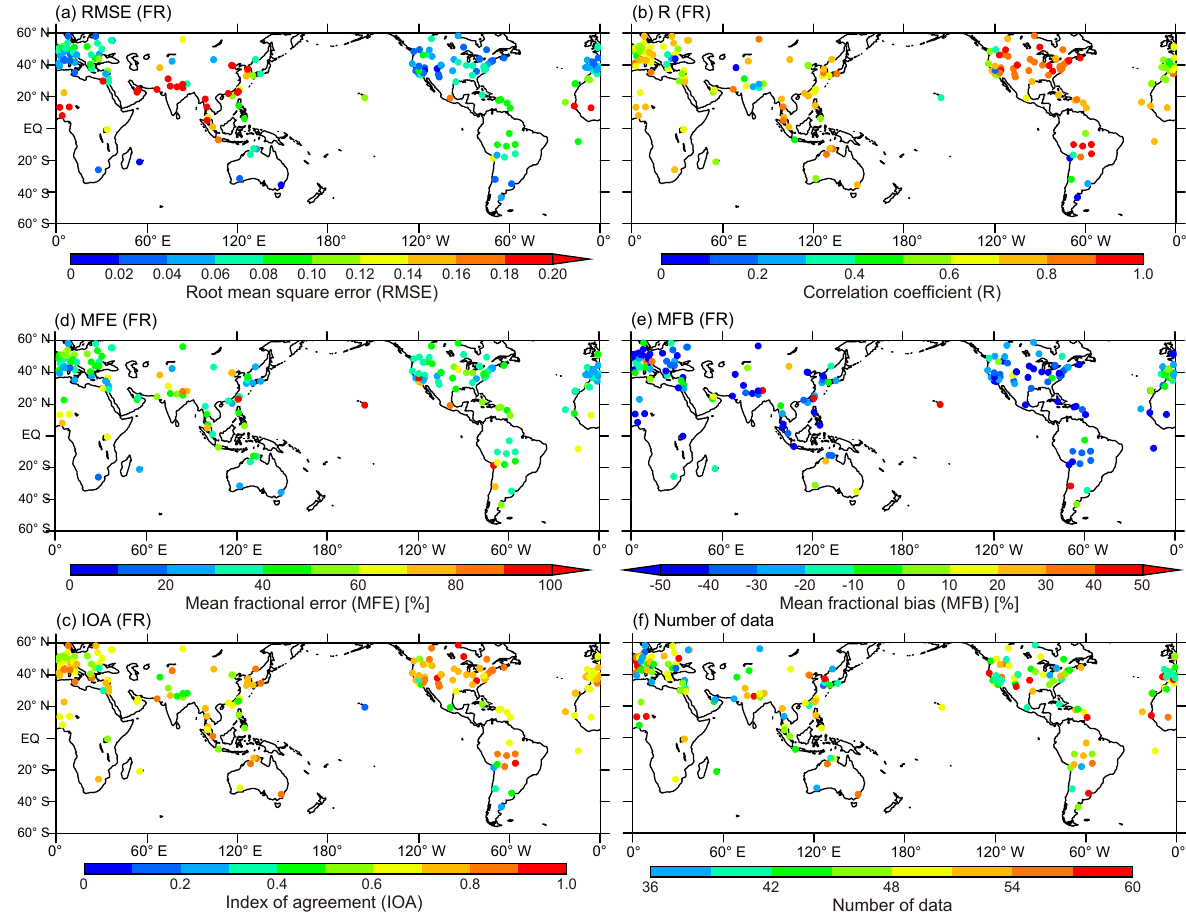
Figure 17. The same as Fig. 16, except versus FR AODs.